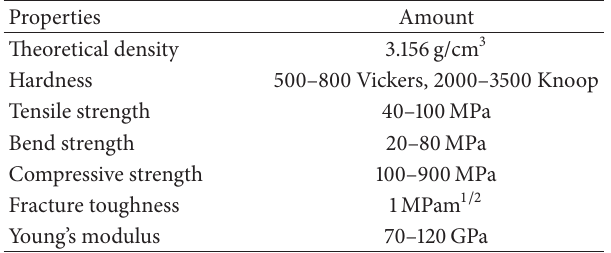
Table 3: Typical properties of dense